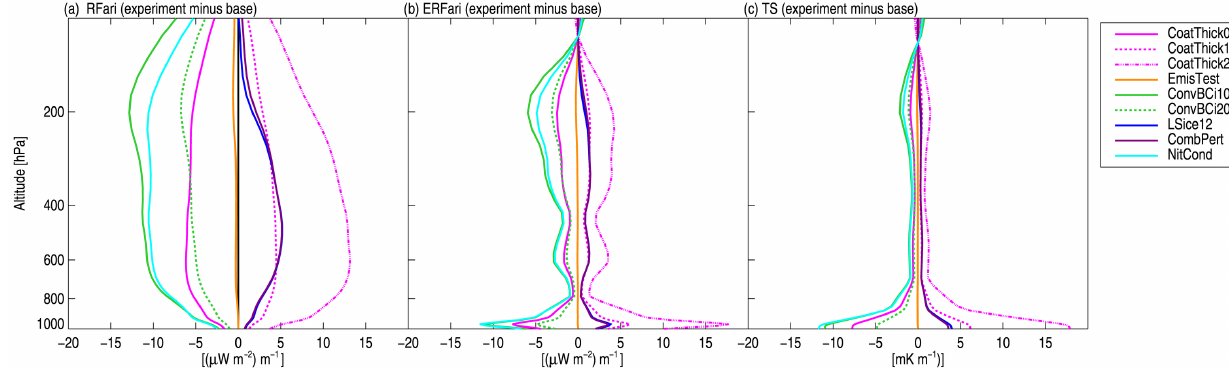
TS. Flanner (2013) imposed BC perturbations at five